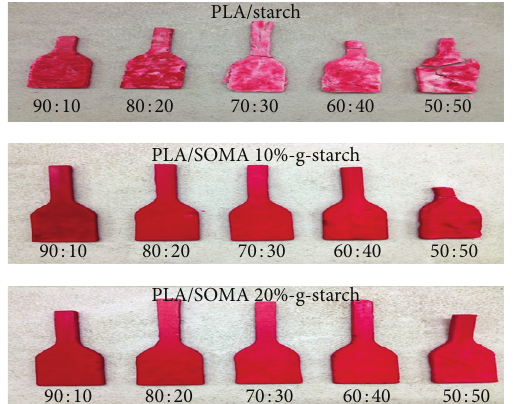
Figure 5: Shows photographs of PLA/SOMA-g-STARCH compos- ites dyed with red disperse dye.